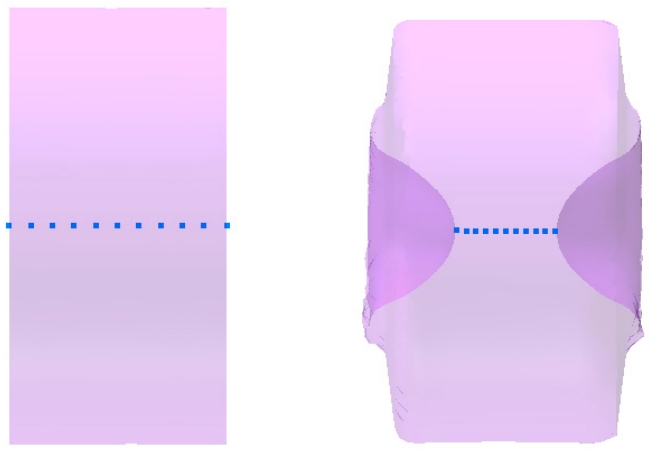
Figure 12. Virtual sensors located in the axis of the sample (every 2 mm) used to record the data characterizing the state of stress and strain: On the left—initial sample and right—the sample after rotational compression.